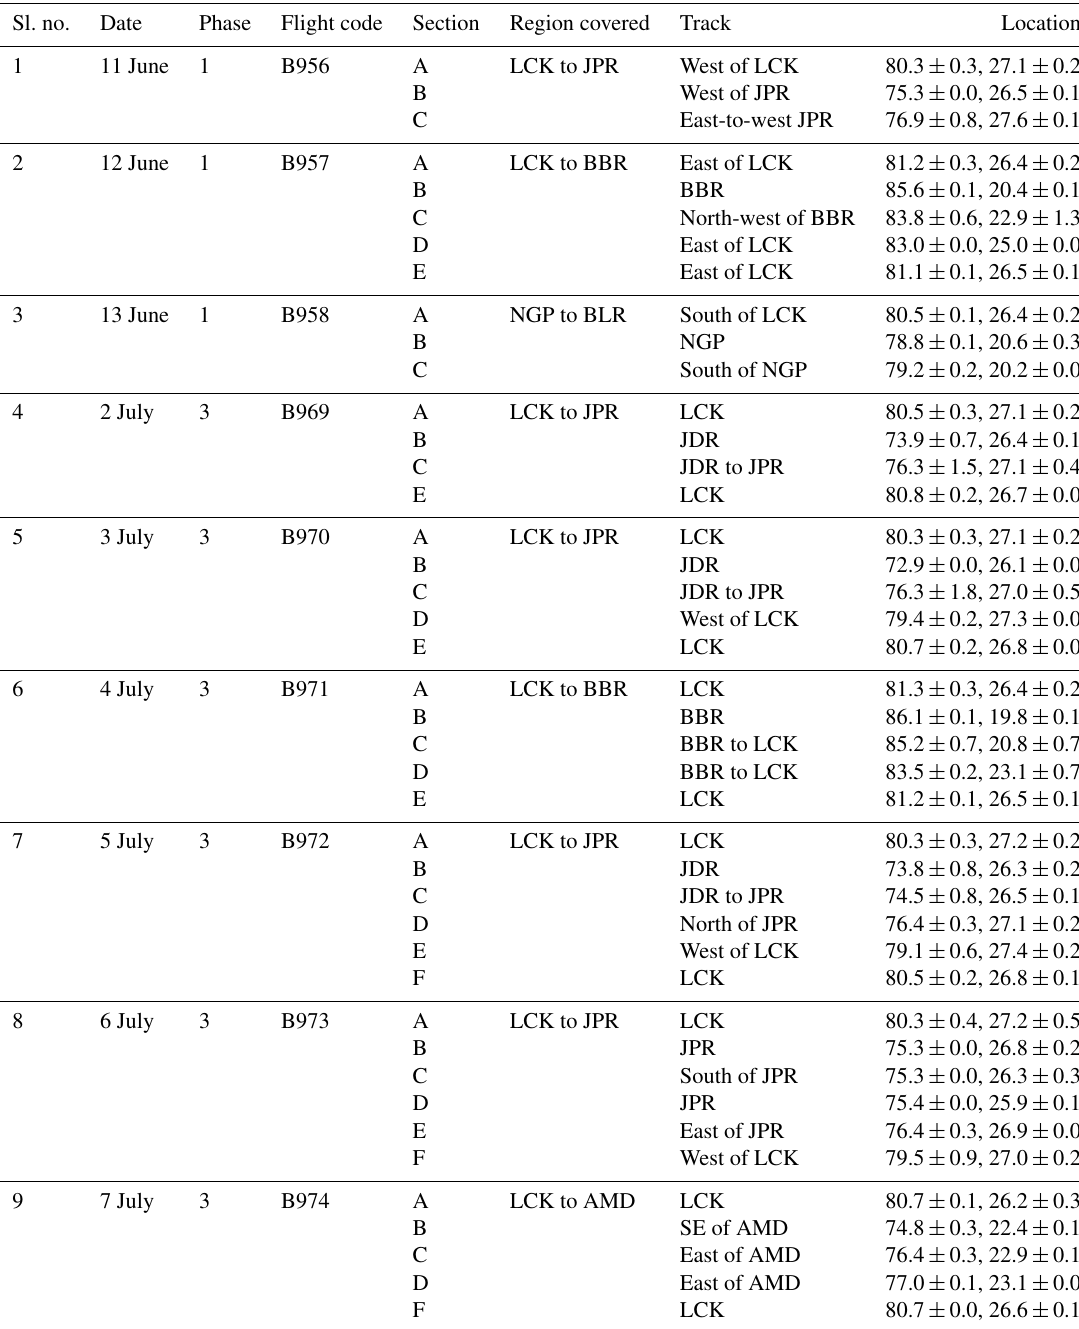
Table 1. Details of measurements. Sl.